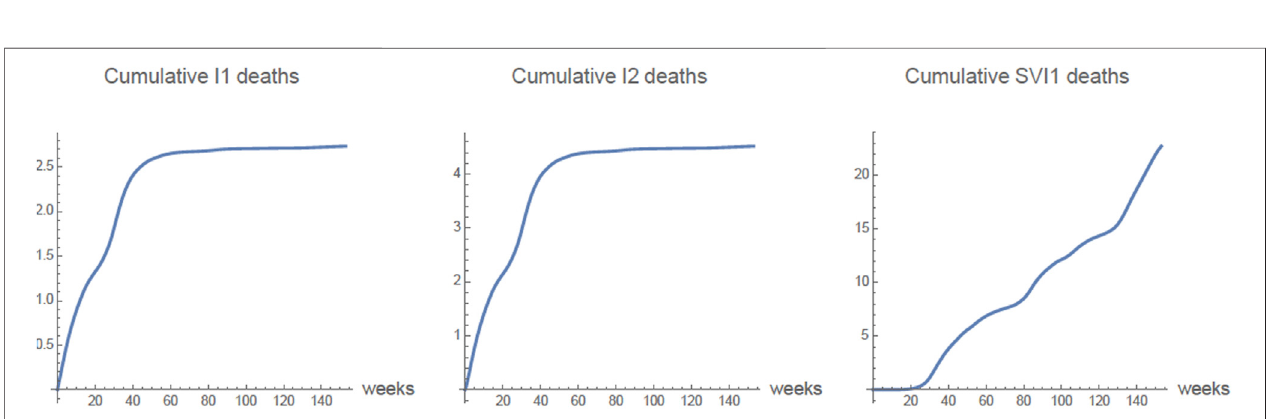
FIGURE 5 | All 875,000 9 years olds are vaccinated. The cumulative number of deaths each week in the compartments I 1 ( t ), I 2 ( t ), SVI 1 ( t ). Most of the deaths occurred in vaccinated 9 year olds, who were not infected before vaccination, and became infected after vaccination as a result of vaccine failure ( SVI 1( t )).